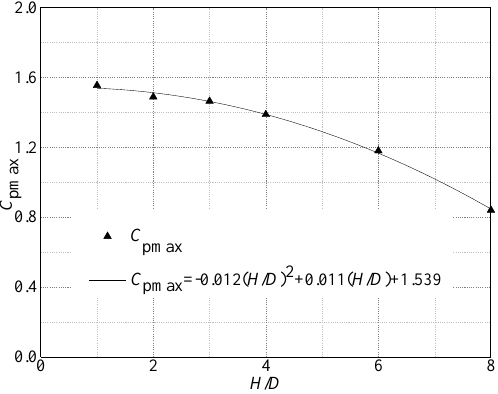
Figure 15. Variation of C pmax as a function of H/D.